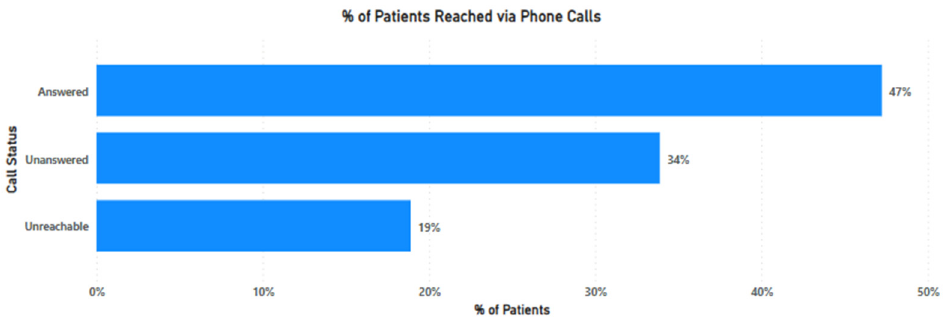
Figure 2. Reach for treatment groups in phone calls channel.